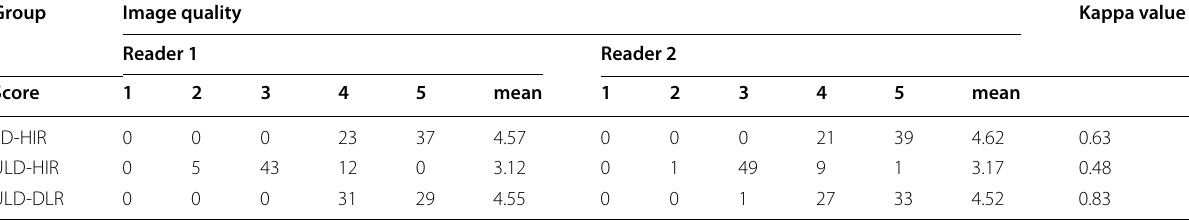
Table 4 Subjective-quality scores of LD-HIR, ULD-HIR, and ULD-DLR